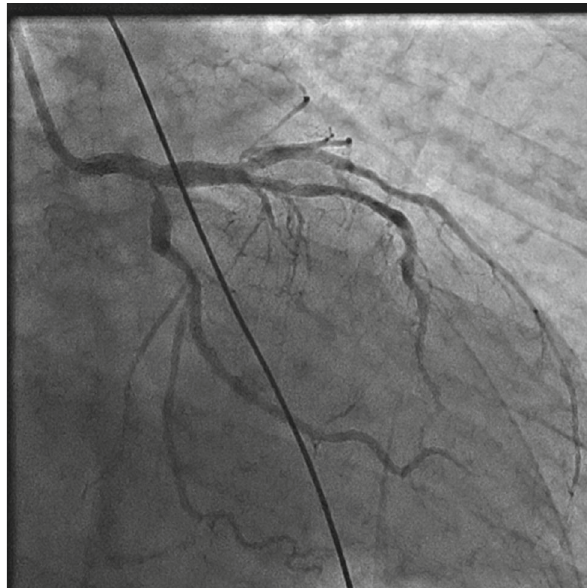
Figure 4: Left coronary artery after stenting LMCA with restoration of blood fl ow.